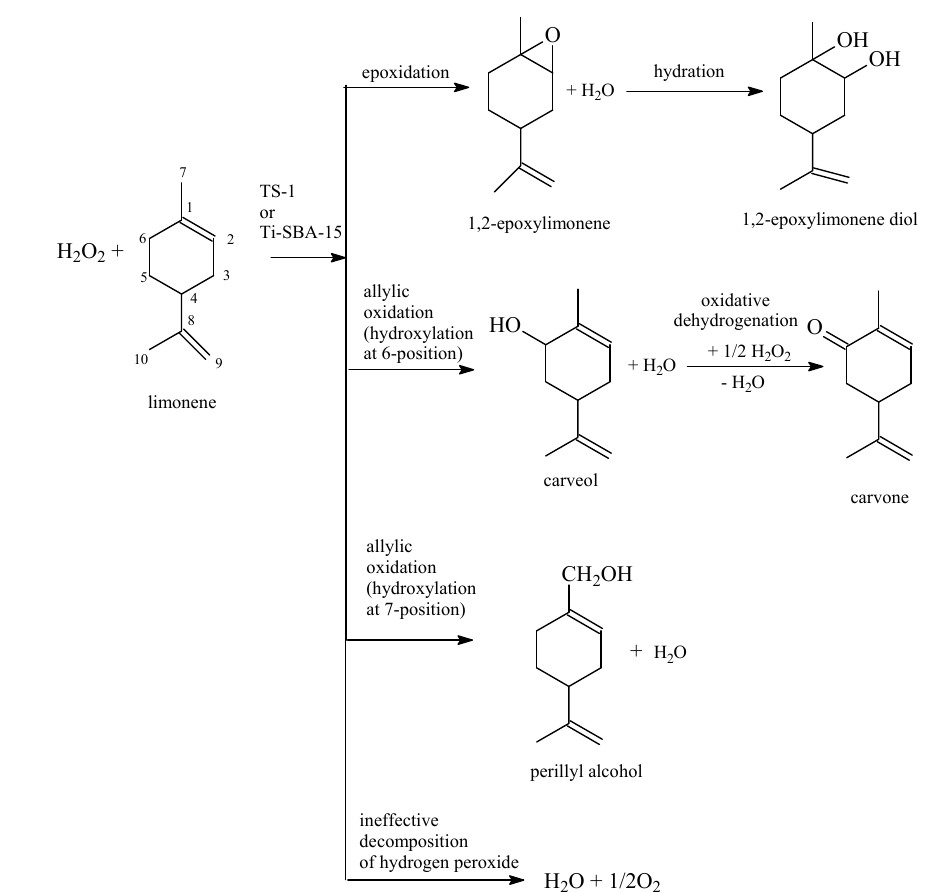
Scheme 1. Reactions during the process of limonene epoxidation over the TS-1 and the Ti-SBA-15